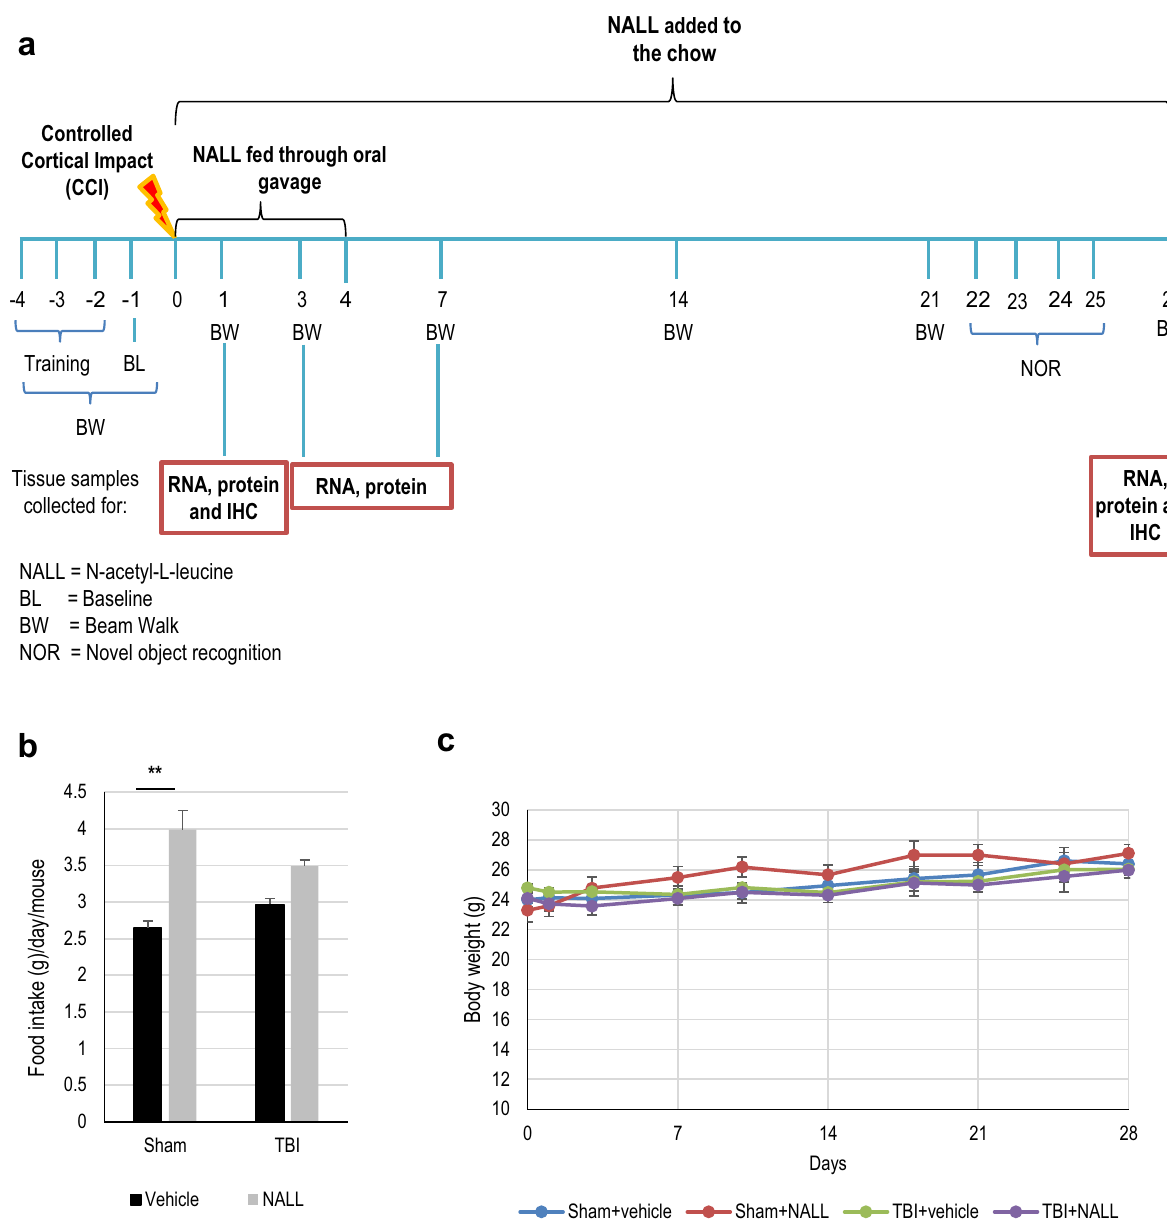
Figure 1. NALL does not affect food intake and body weight in mice. ( a ) NALL treatment strategy. Mice were orally fed with NALL and cortical tissues were collected at days 1, 3 and 7 after TBI for biochemical analyses. BW beam walk, NOR novel object recognition, BL Baseline ( b ) Amount of NALL containing chow eaten by the mice. ( c ) Body weight of sham and injured mice fed with vehicle or NALL. No significant differences were observed between corresponding vehicle and NALL groups. Data are presented as mean ± SEM. n = 10 sham + vehicle, 9 sham + NALL, 20–25 TBI + vehicle and 18 TBI + NALL. **p < 0.001 (Two-way ANOVA with Sidak